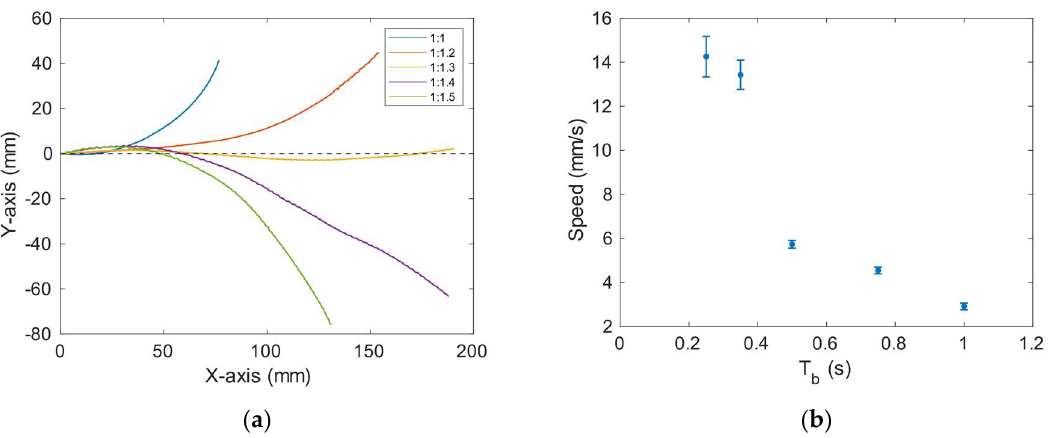
Figure 11. ( a ) Path followed by the robot depending on the T ON ratio between plates. ( b ) Linear speed as a function of T b . Symbols represent the average of 3 measurements.